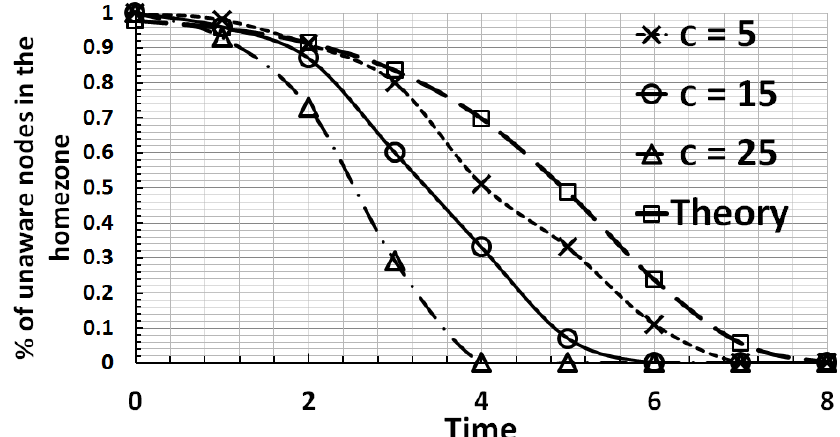
Figure 3. The proportion of nodes that have not learned about the duplicate, as a function of consecutive cycles of the Discard algorithm. The expected size of the home zone is 45 nodes. The plot points are averages of 100